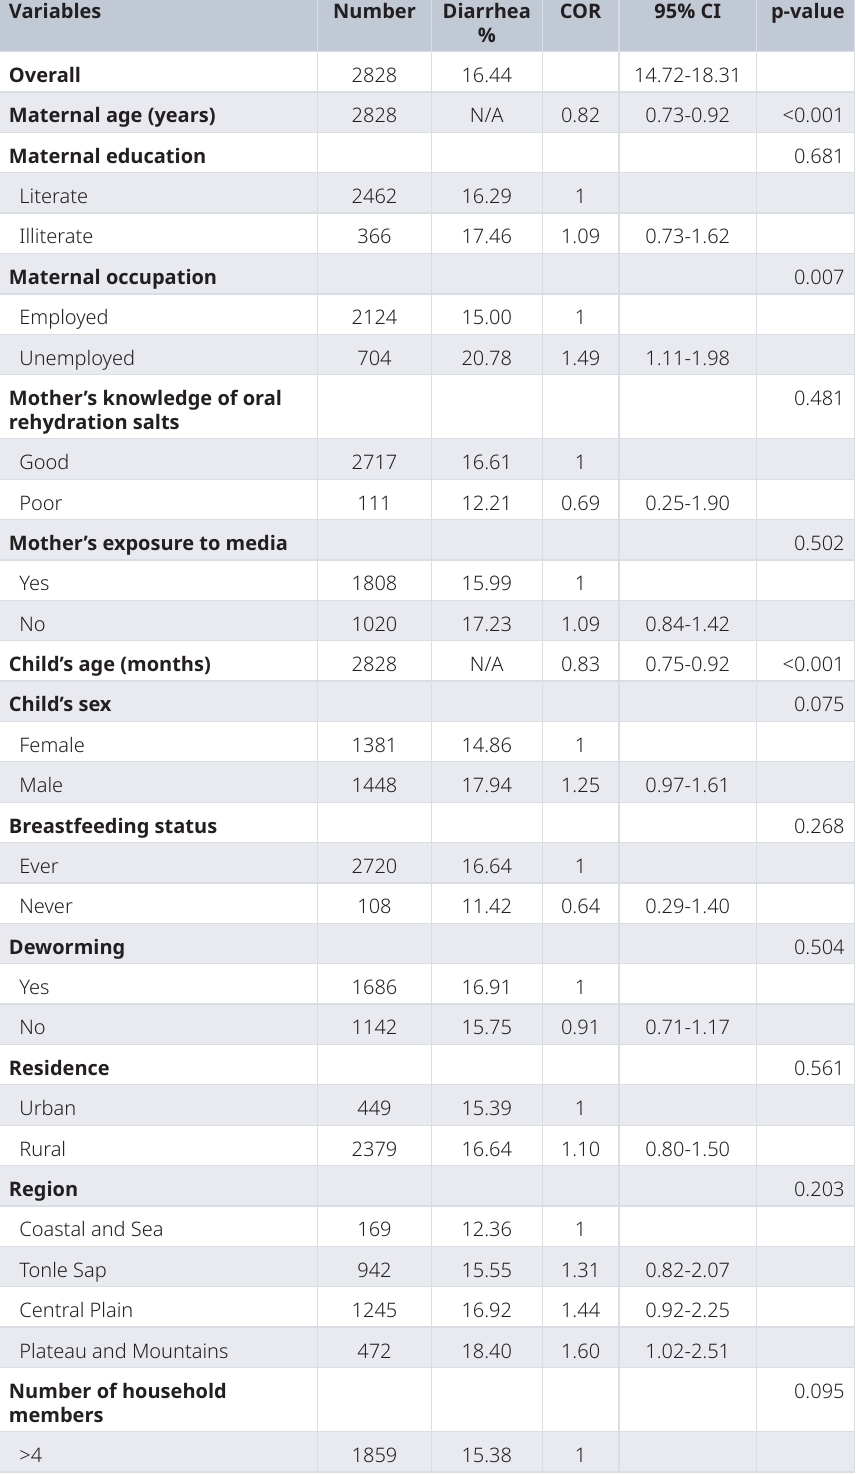
Table 4. Bivariate analysis of factors associated with childhood diarrhea in Cambodia, 2014 (n=2,828).